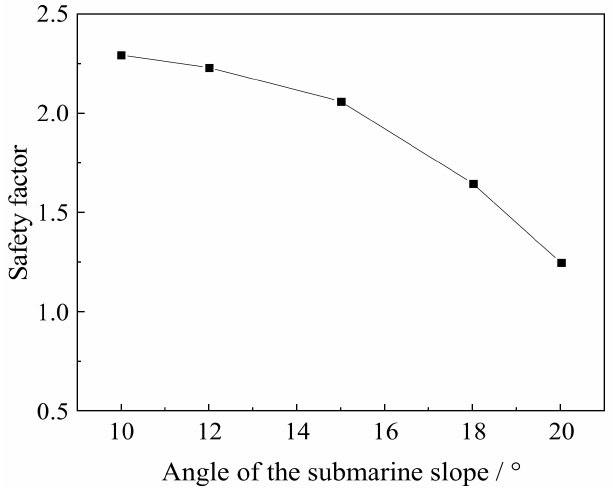
Figure 14. Safety factors corresponding to different slope